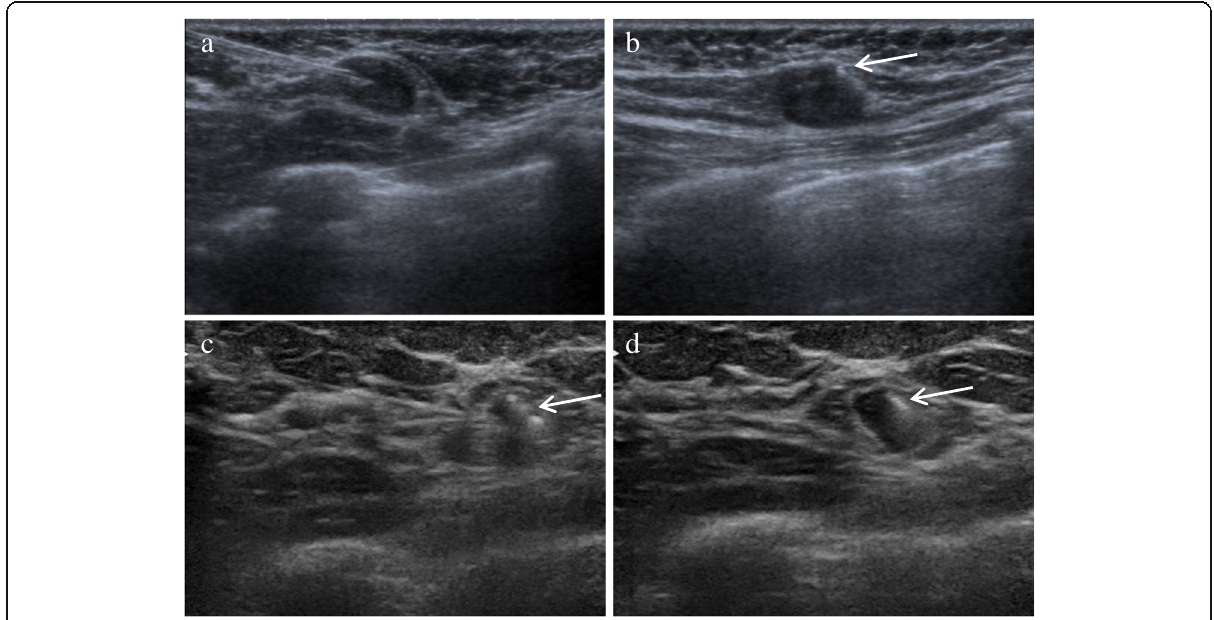
Fig. 1 Axillary ultrasound images of a patient with a proven tumor-positive lymph node prior to neoadjuvant systemic treatment (NST). a A needle was inserted in the sonographically hypoechoic axillary lymph node to place an O-twistmarker (white arrow) inside ( b ). After NST ( c ), the O-twistmarker was located and a needle was inserted in the lymph node that was no longer suspicious on ultrasound. d After injection of 0.2 ml Tc-99m-MAA, a hypoechoic lymph node was observed. Histopathological assessment showed that this node was converted into a node-negative